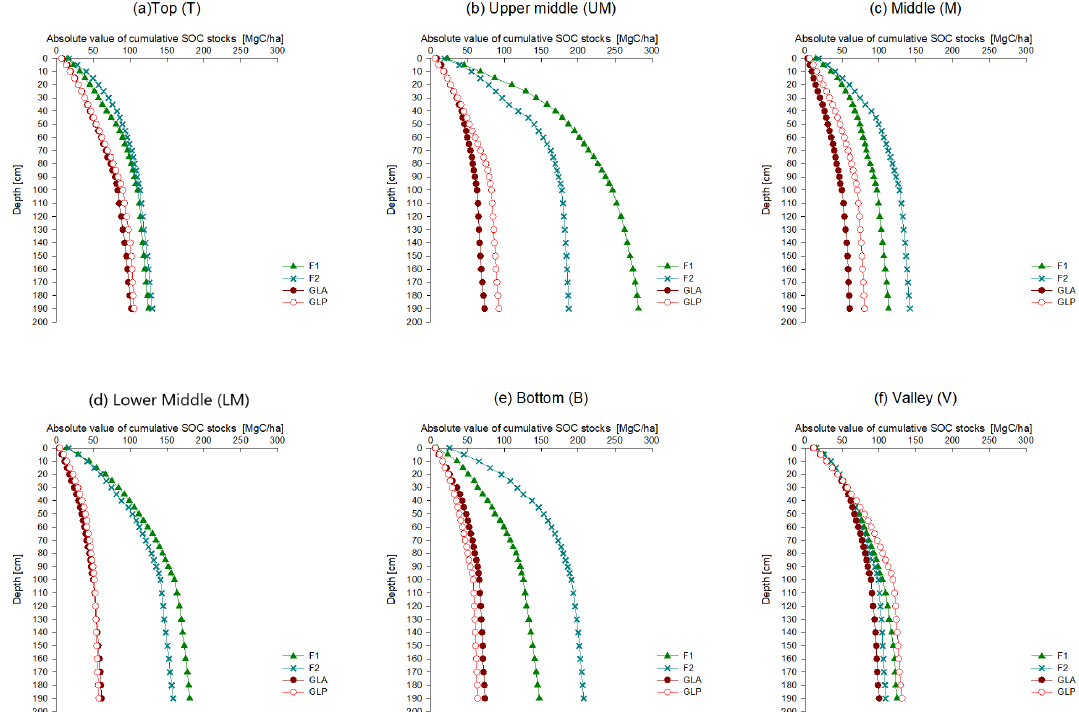
Figure 4. Absolute values of cumulative SOC stocks of hillslopes F1, F2, GLA and GLP plotted together for each sampling location: (a) Top,